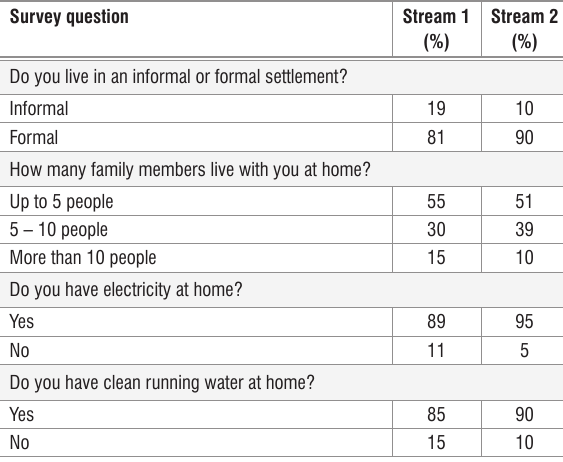
Table 2 addresses concerns of poor schooling environments and poor